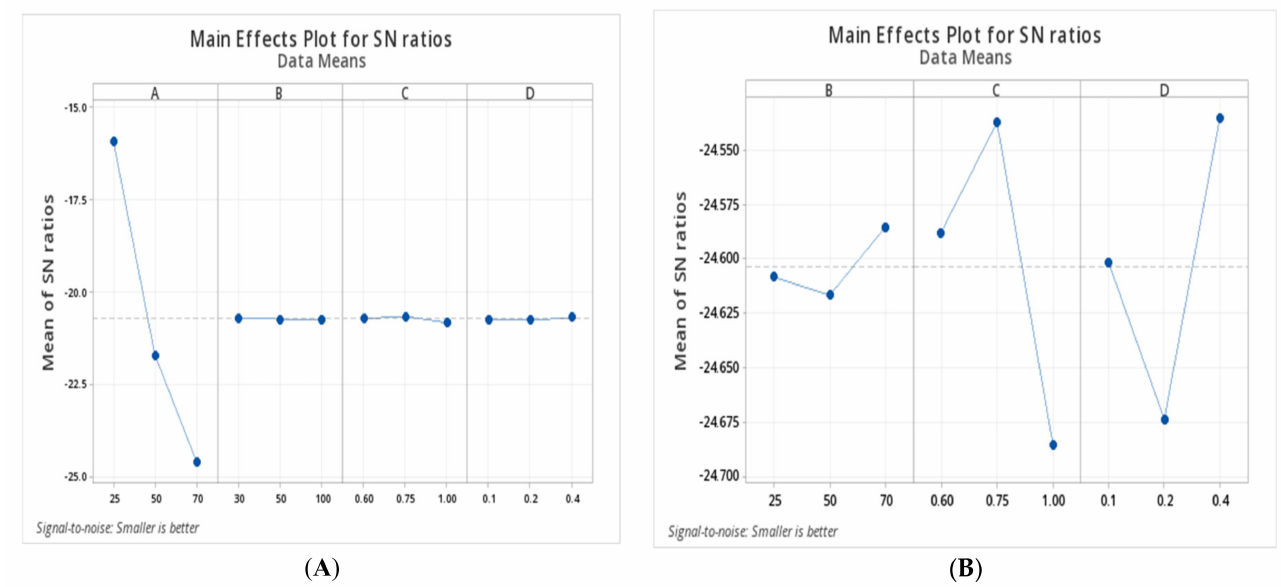
Figure 6. Main effects plot for the SN ratio of NSGA-II in ( A ) round 1 and ( B ) round 2.